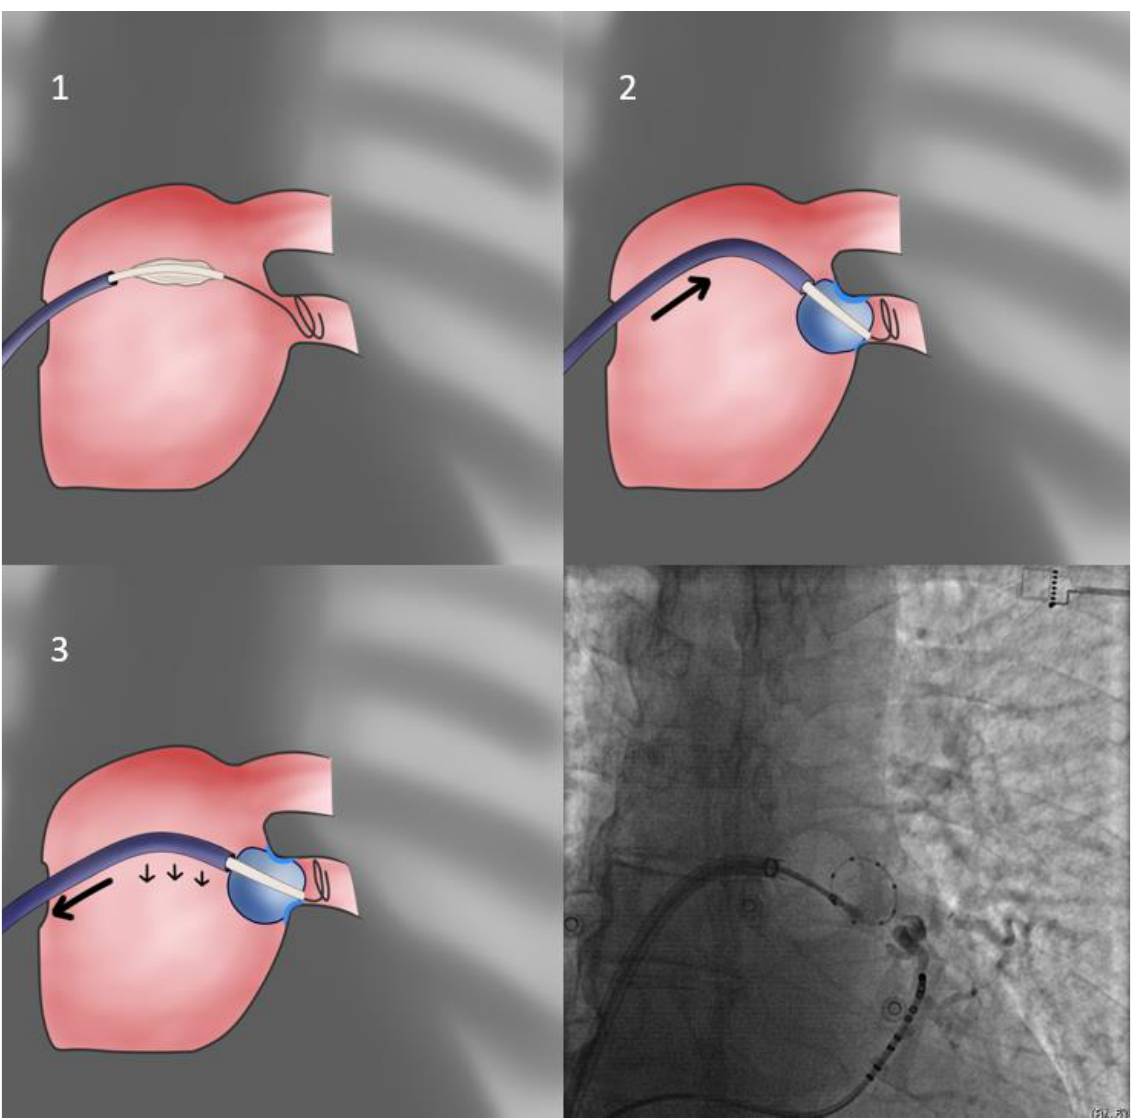
Figure 2. Hockey stick approach. This variation of the direct approach for the isolation of the inferior veins involves curving the catheter shaft more than in the direct approach, to take advantage of the more upward oriented inferior vein ostium orientation. Once proper alignment in the poste- rior/anterior plane is achieved (contralateral view is used—not shown) and the catheter, as well as the balloon, shafts are flexed, forward pressure leads to antral occlusion, with pressure mostly directed to the upper semicircle of the occlusion line. Consequently, after 60 s the pulldown maneuver is performed, with slight removal of flexion and gentle retraction of the catheter sheath to achieve greater contact force with the inferior part of the occlusion line